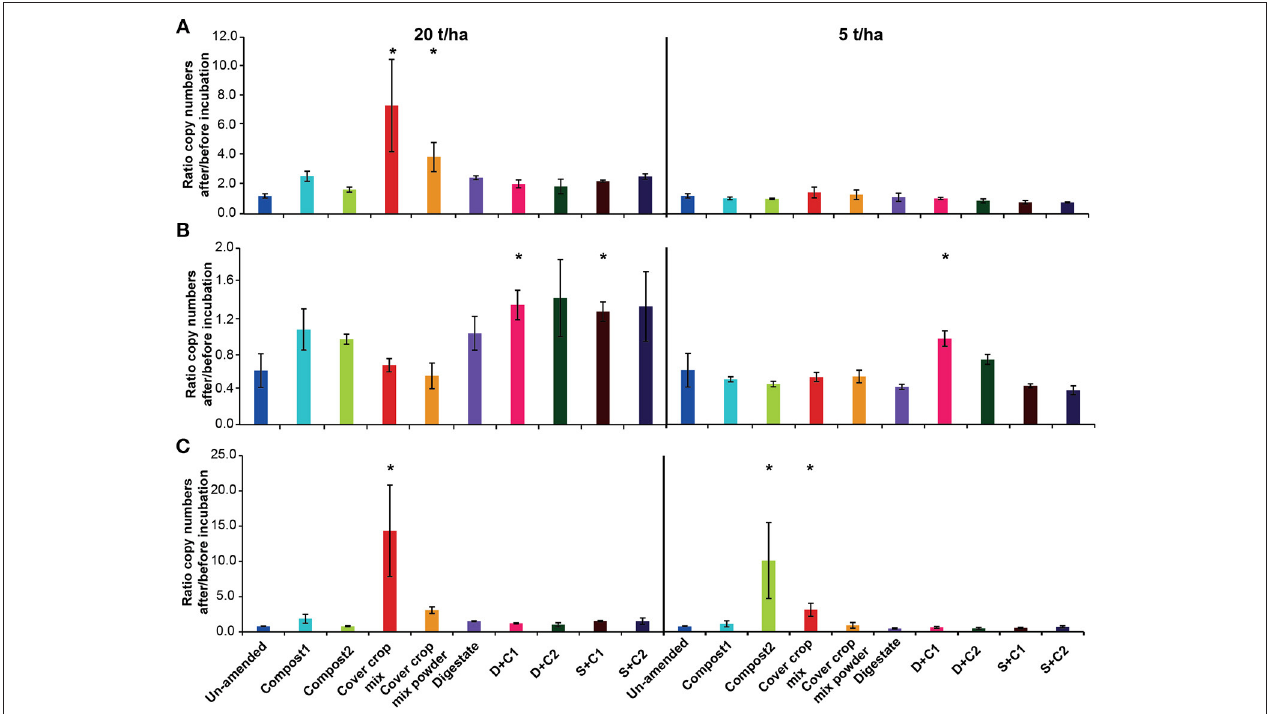
FIGURE 6 | Ratio of the copy numbers of (A) bacterial 16S rRNA gene, (B) archaeal 16S rRNA gene, and (C) fungal 18S rRNA gene after and before an incubation of un-amended clay soil and during amendments with compost1, compost2, CC residues mixtures, digestate, digestate + compost1, digestate + compost2, sewage sludge + compost1 and sewage sludge + compost2 (mean ± SD; n = 3) for 28 d. Asterisk (*) indicate significant differences in the ratio of the individual genes in the soils with organic amendments and the un-amended soil within the four separate superordinate treatments (ANOVA: P <